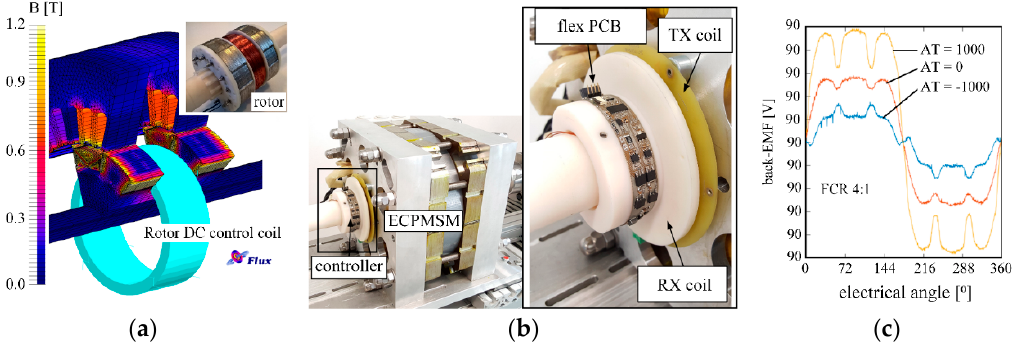
Figure 6. ( a ) 3D-FE model with rotor DC control coil location; ( b ) Machine prototype with contactless energy transfer system; ( c ) Experimental results of no-load induced voltage in phase winding at the different DC coil MMF of ECPMS-machine [54].